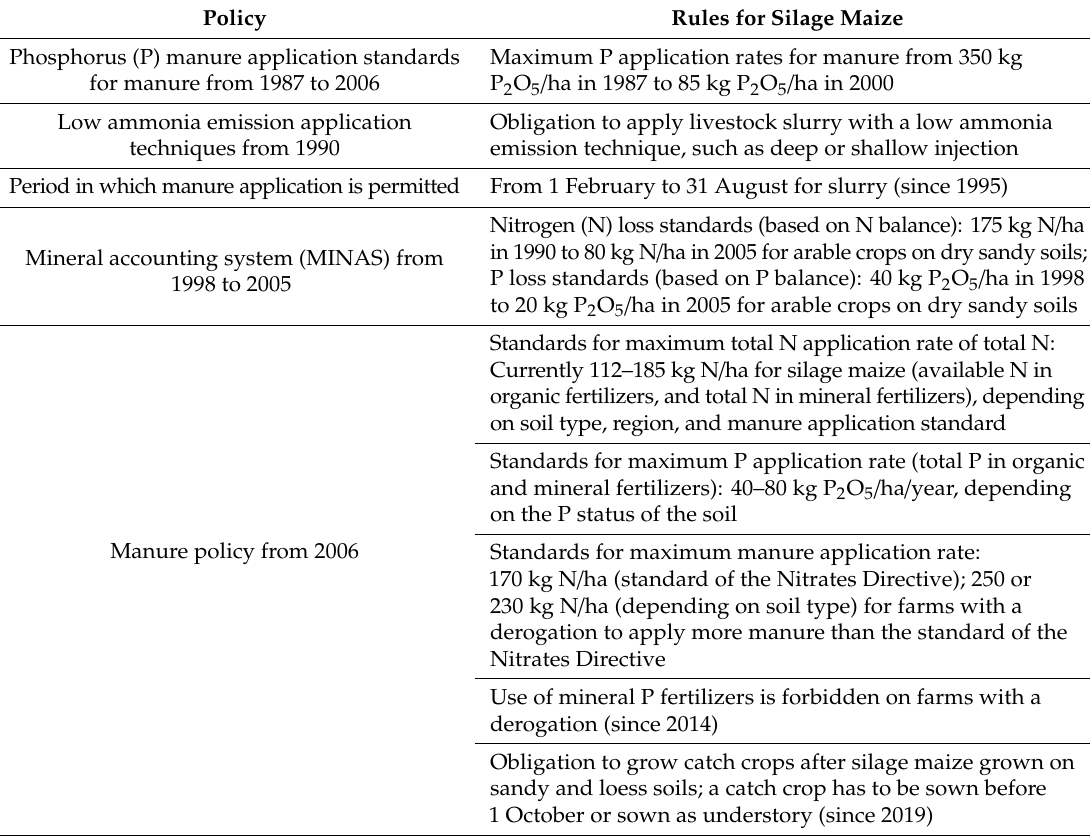
Figure 1. Trends of the area and DM yields of silage maize in the Netherlands (source: Statistics Netherlands; www.cbs.nl). Table 1. Nutrient management policy of silage maize cultivation in the Netherlands.